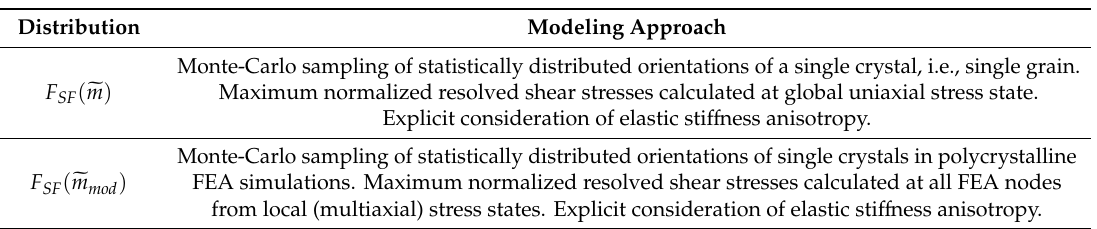
Table 2. Overview of Schmid factor distribution